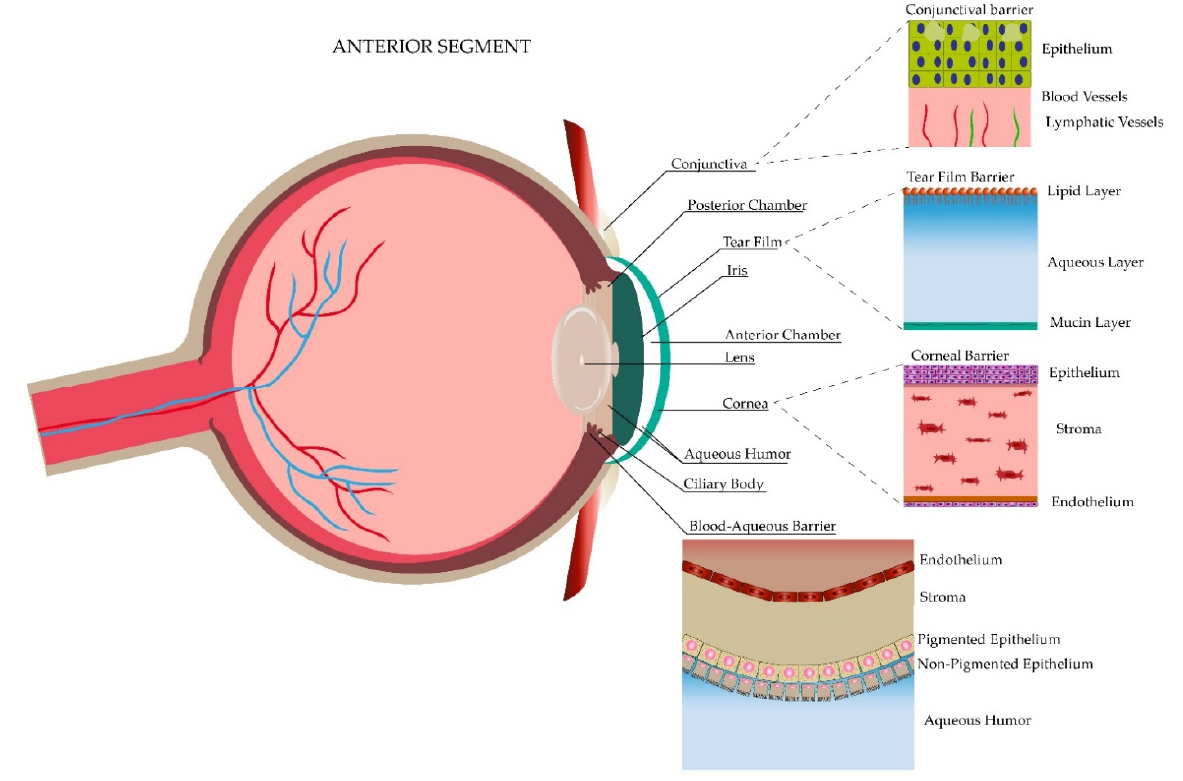
Figure 1. Anterior segment of the eye.